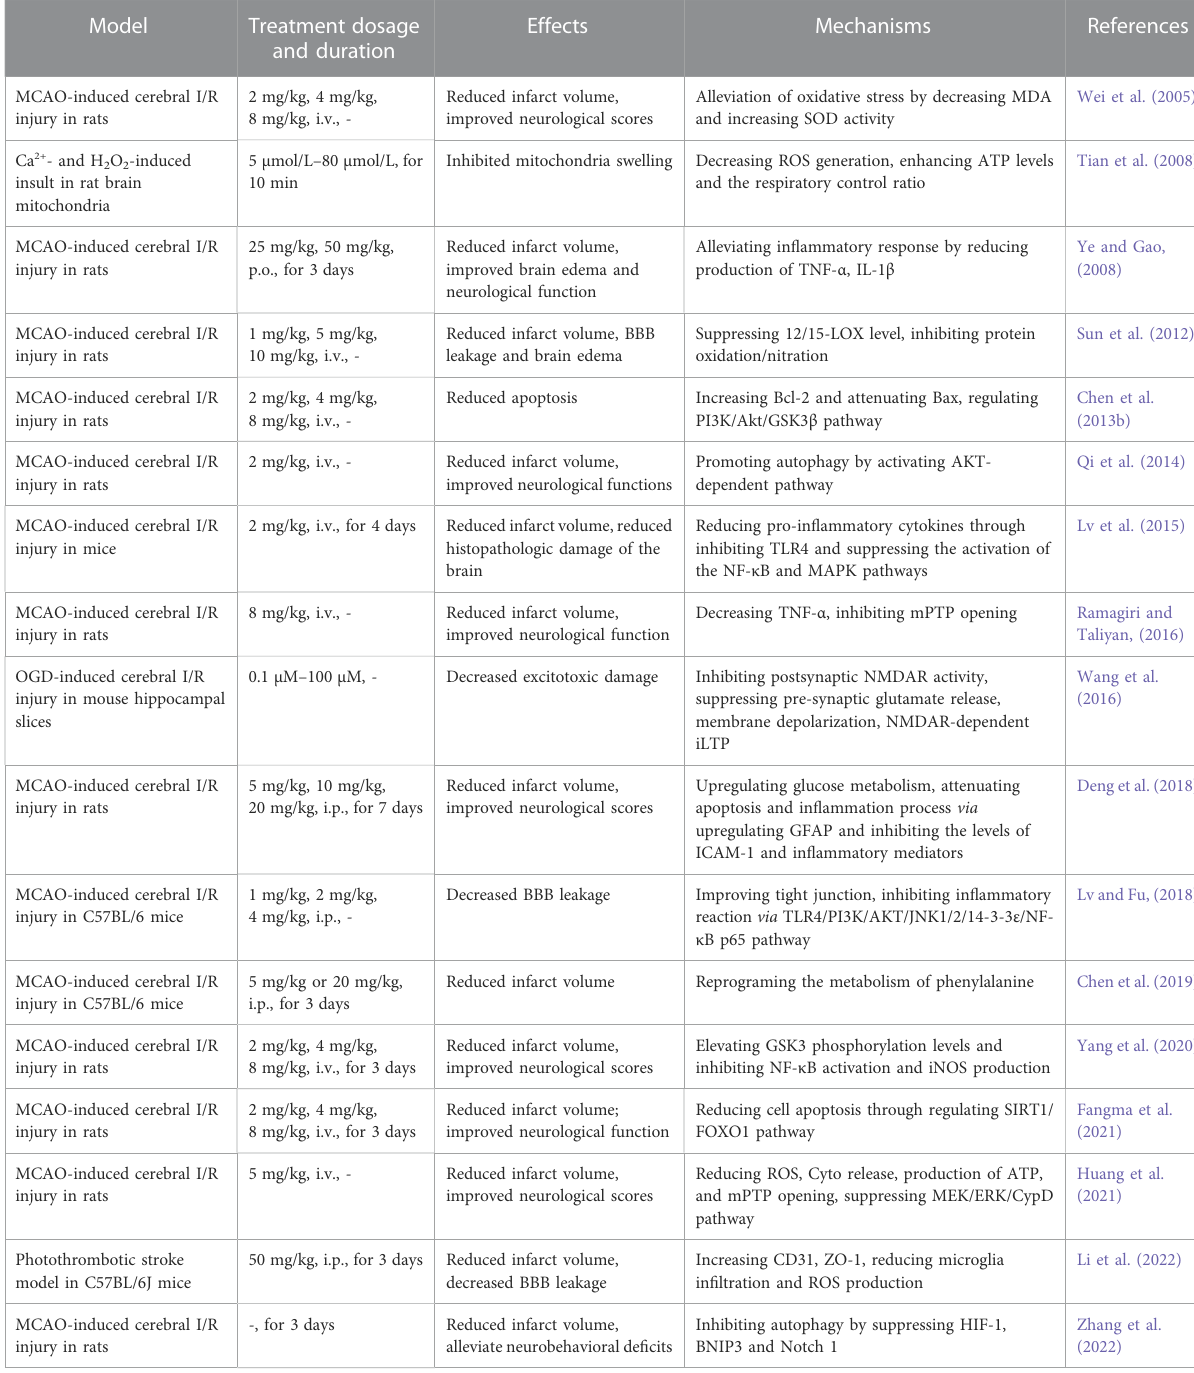
TABLE 1 Protective effects of HSYA against cerebral I/R injury under in vivo